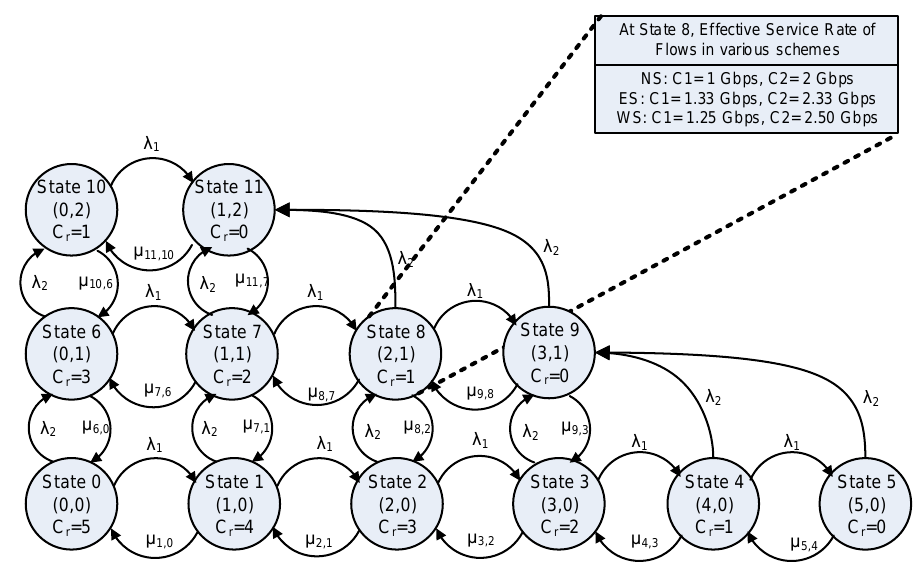
Figure 8. Sample two-dimensional Continuous Time Markov Chain (CTMC) for two classes with MRR c = c Gbps ∀ c ∈ { 1, . . . , R } and link capacity C = 5 Gbps.